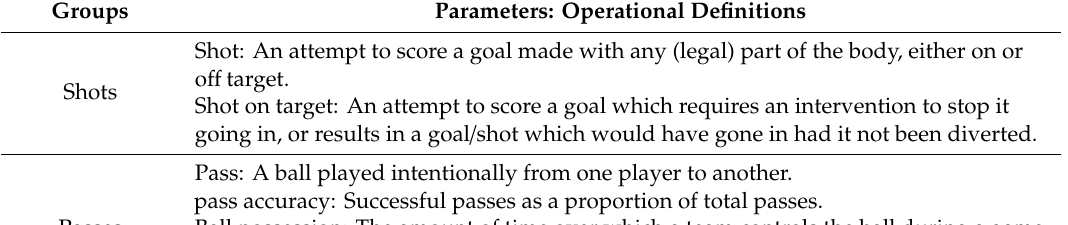
Table 1. Types of technical activity engaged in by players, and their operational definitions. Groups Parameters: Operational